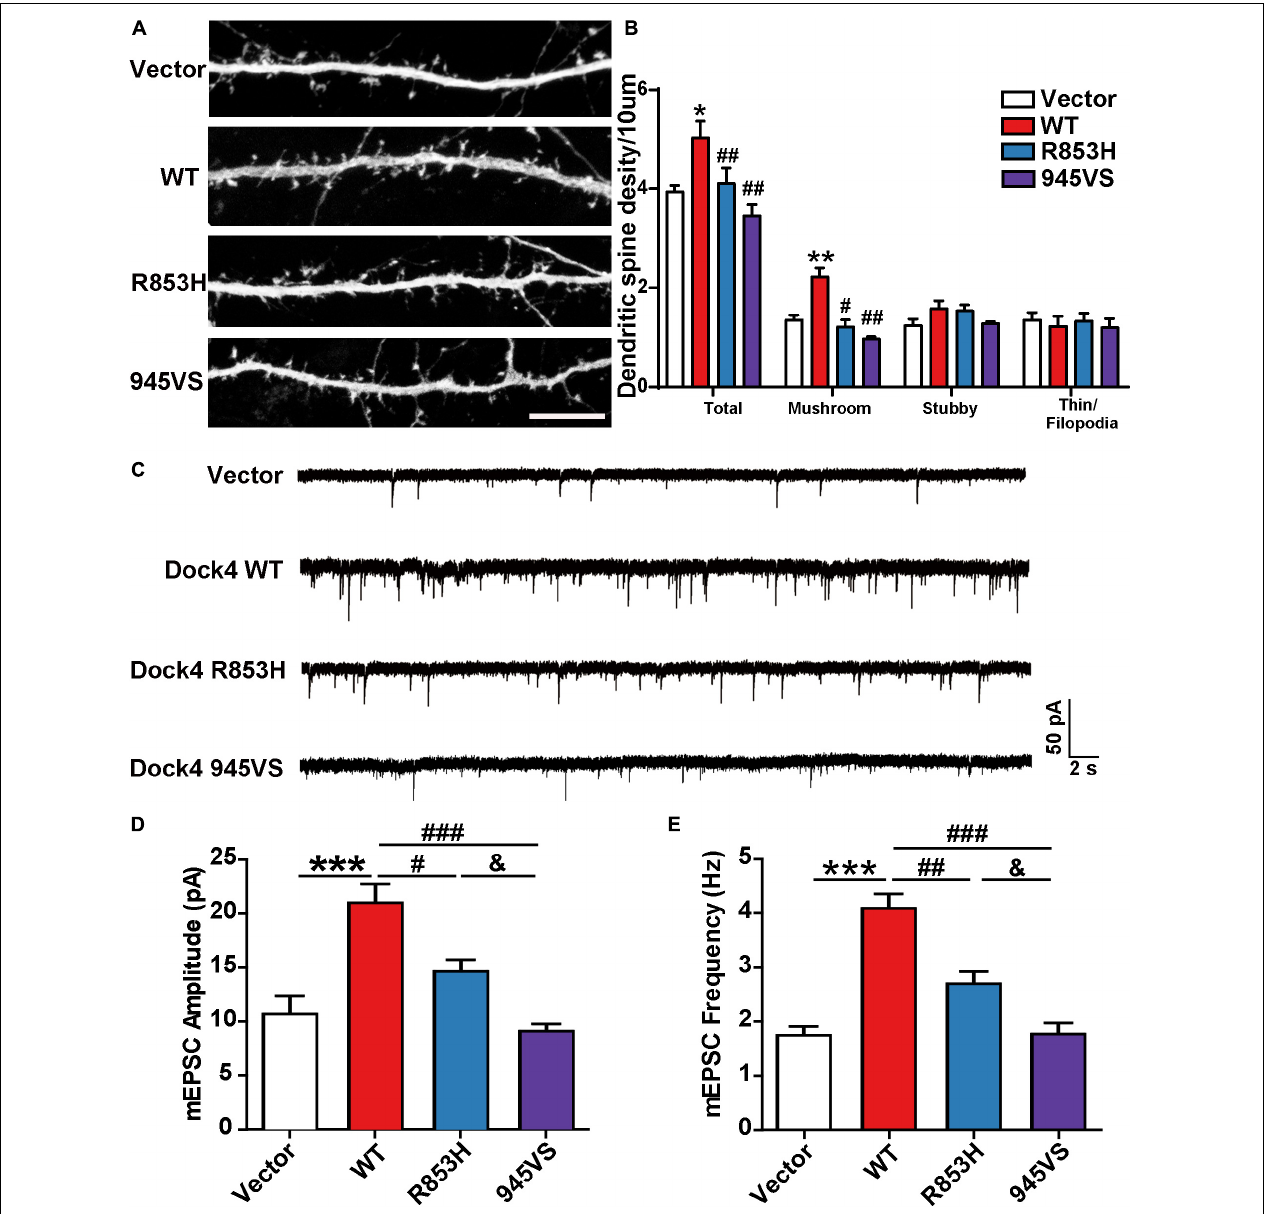
FIGURE 6 | Dock4-R853H and 945VS have compromised abilities to promote dendritic spine morphogenesis and synaptic transmission. (A) Dock4 mutants could not promote dendritic spine formation in hippocampal neurons. 9 DIV hippocampal neurons were transfected with plasmids expressing Dock4-WT, Dock4-R853H, Dock4-945VS or Vector and analyzed at 16 DIV. Scale bar, 10 µ m. (B) Density of total spines and different types of spines were measured. Data are shown as mean ± SEM from three independent experiments. ∗ P < 0.05, ∗∗ P < 0.01, # P < 0.05, ## P < 0.01, one-way ANOVA. At least 30 cells/group were analyzed in each experiment. (C) Miniature excitatory postsynaptic currents (mEPSCs) of hippocampal neurons expressed with Dock4-WT, Dock4-R853H, Dock4-945VS or Vector. Amplitude (D) and frequency (E) were quantified. ∗∗∗ P < 0.001, # P < 0.05, ## P < 0.01, ### P < 0.001, & P < 0.05, one-way ANOVA. At least 10 cells/group were analyzed in each